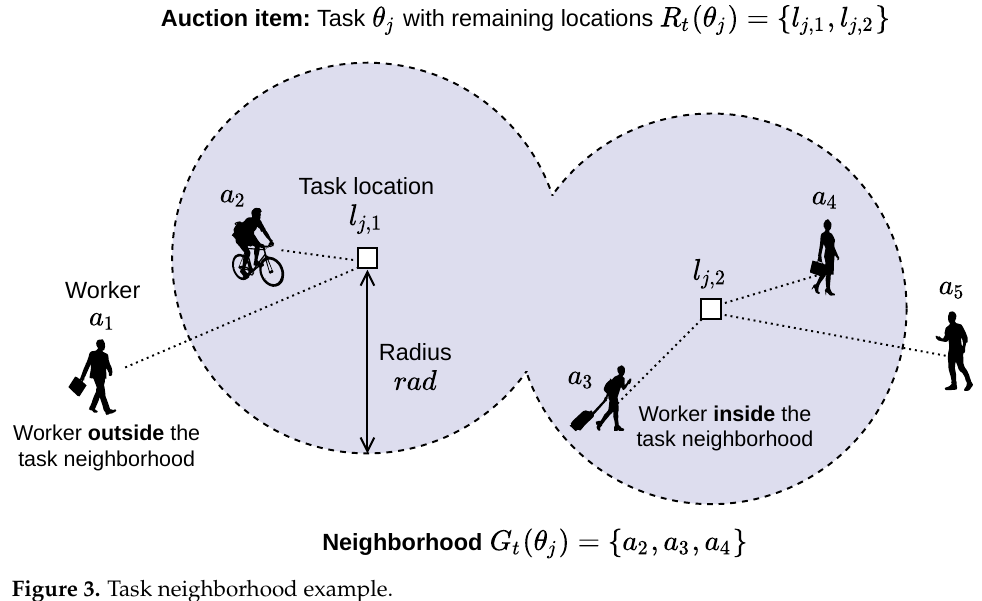
Figure 3. Task neighborhood